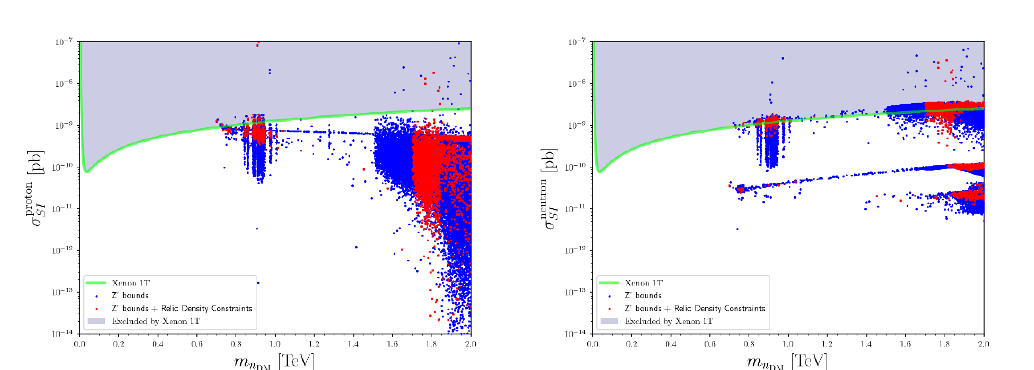
Figure 4 . DM-proton (left) and DM-neutron (right) spin-independent scattering cross section as a function of the mass of the lightest scotino m n . Red points represent the scenarios featuring a DM relic density consistent with Planck data, and blue point any other scenario returned by the